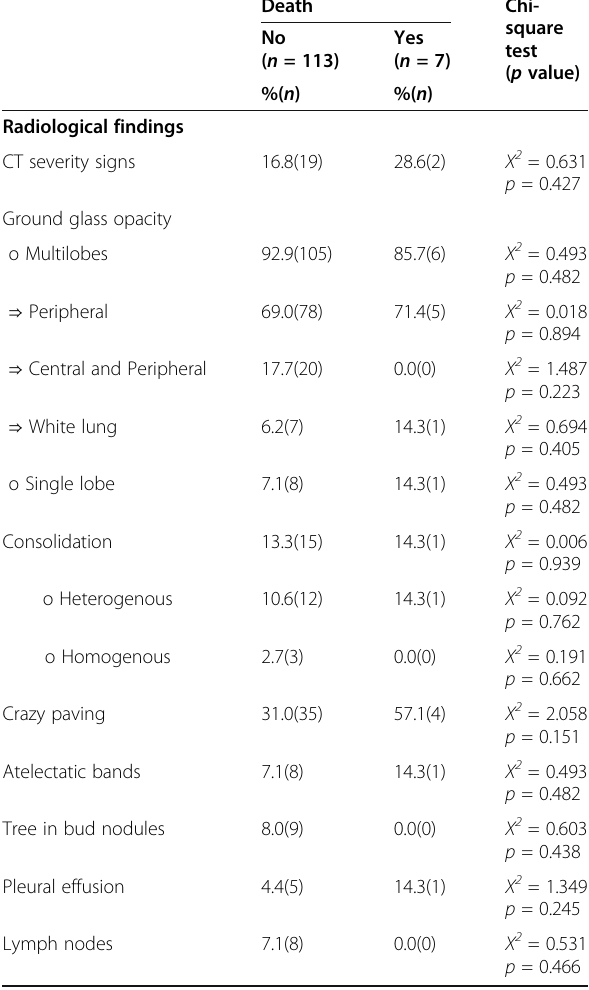
Table 7 Association between radiological findings with death